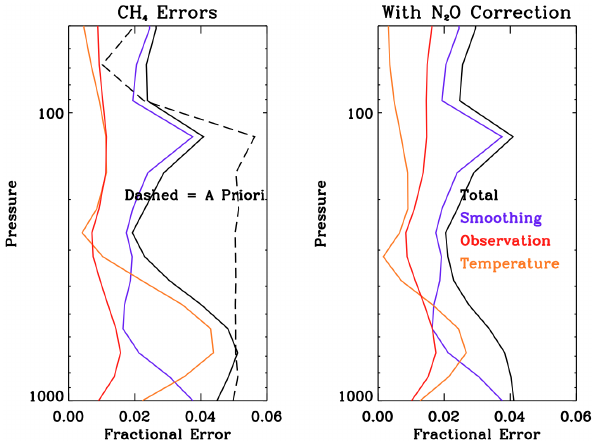
Figure 9: Error budget for the methane estimate before and after correcting the Fig. 9. Error budget for the methane estimate before and after cor- methane profile with the ratio of the TES estimated N 2 O and the TES N 2 O a priori . Observation error is the sum of the measurement error related to noise and due to recting the methane profile with the ratio of the TES estimated N 2 O jointly estimated parameters. The total error is the sum of the smoothing, and the TES N 2 O a priori. Observation error is the sum of the mea- observation, and temperature error. surement error related to noise and due to jointly estimated param- eters. The total error is the sum of the smoothing, observation, and temperature error.